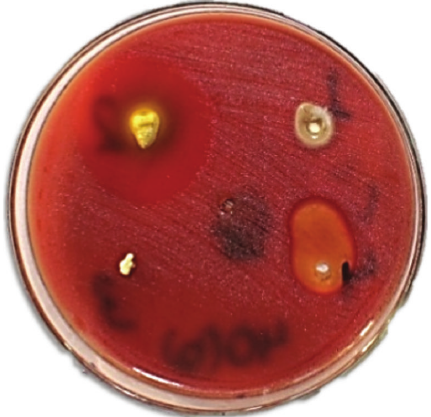
Figure 6: Culture and sensitivity test: triple antibiotic paste with largest inhibition zone in upper left region.